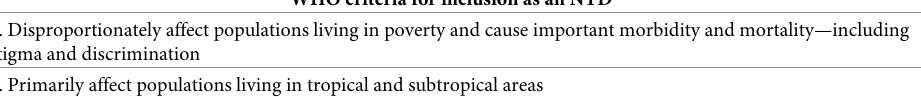
Table 1. WHO criteria for inclusion as an NTD. WHO criteria for inclusion as an NTD